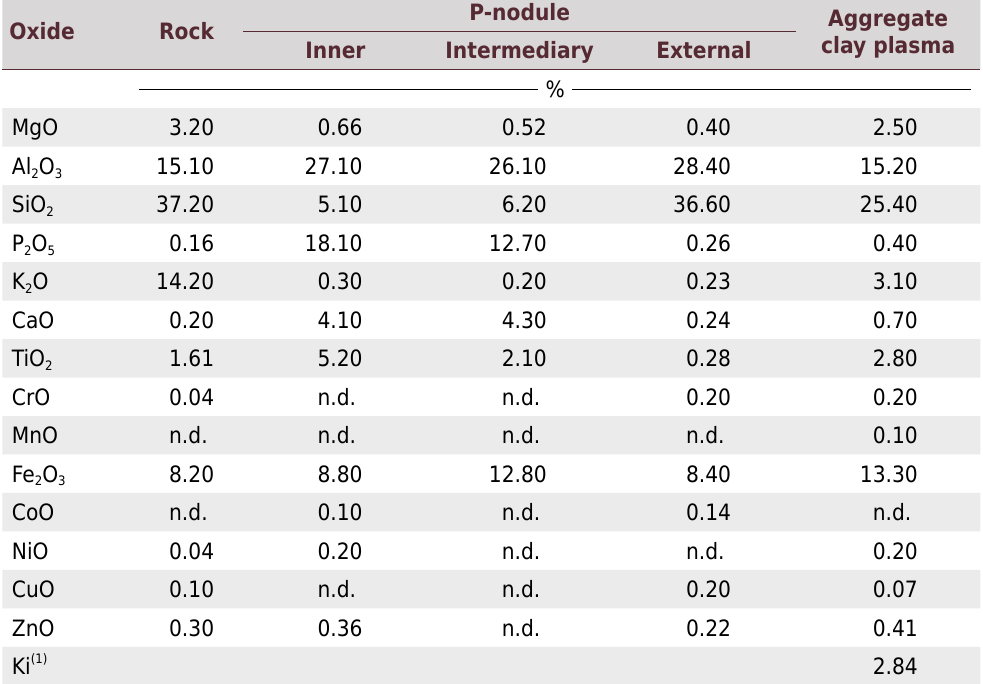
Table 3. The SEM-WDS microchemical analysis of selected pedofeatures of the Bi horizon in the